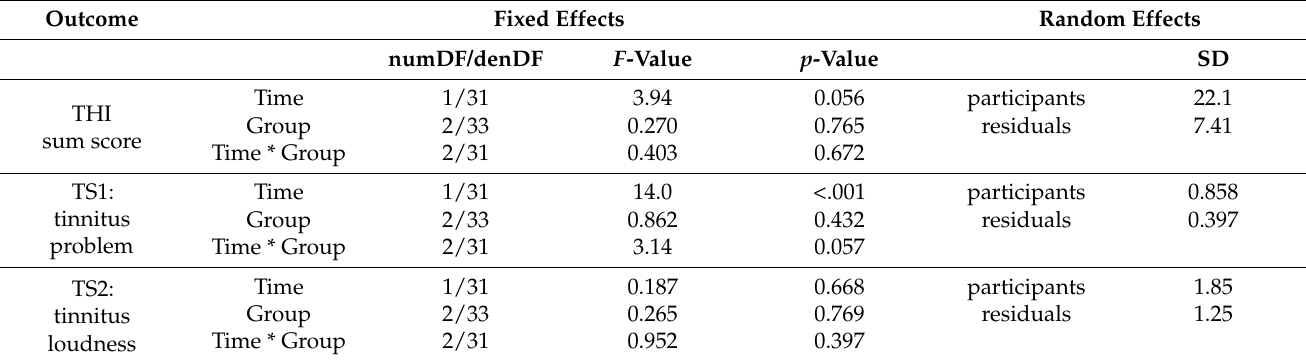
Table 2. Results of the mixed effects models for tinnitus outcome